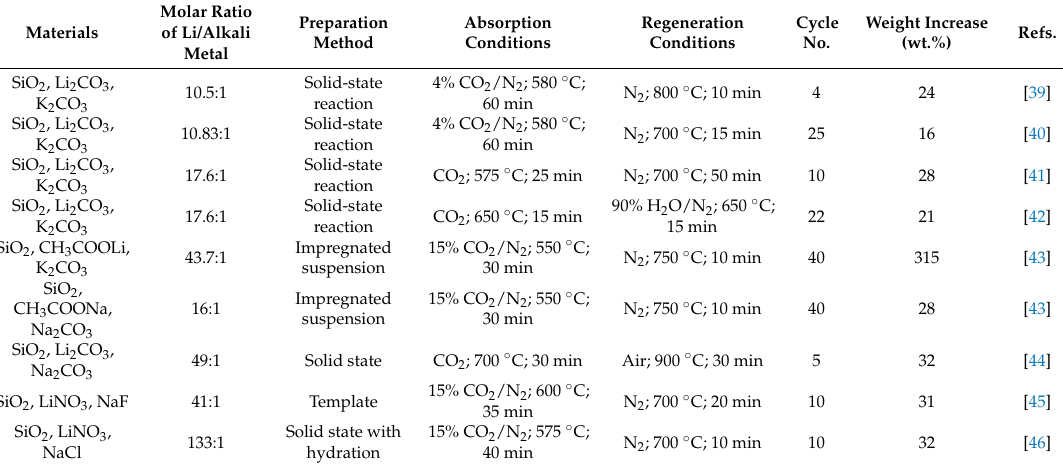
Table 2. Summary of CO 2 absorption performance of Na and K doped Li 4 SiO 4